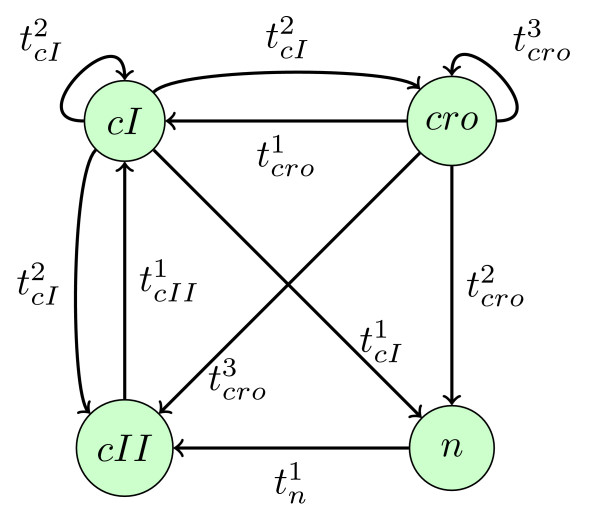
Interaction graph  for the model about immunity control by the λ phage.